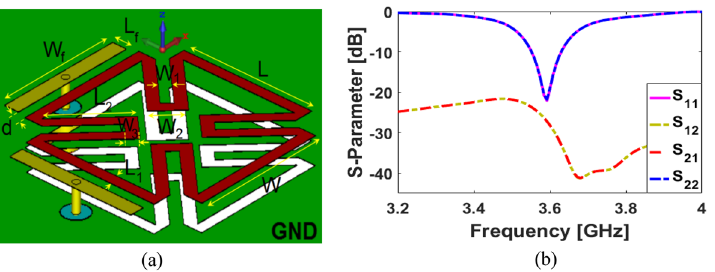
Figure 1. ( a ) Patch-slot antenna with double-fed self-complementary configuration and ( b ) its S-parameters.